Question: Looking at the figure, what chart type is it?
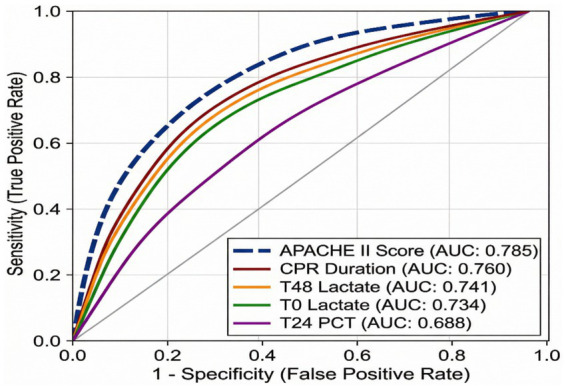
Answer: line